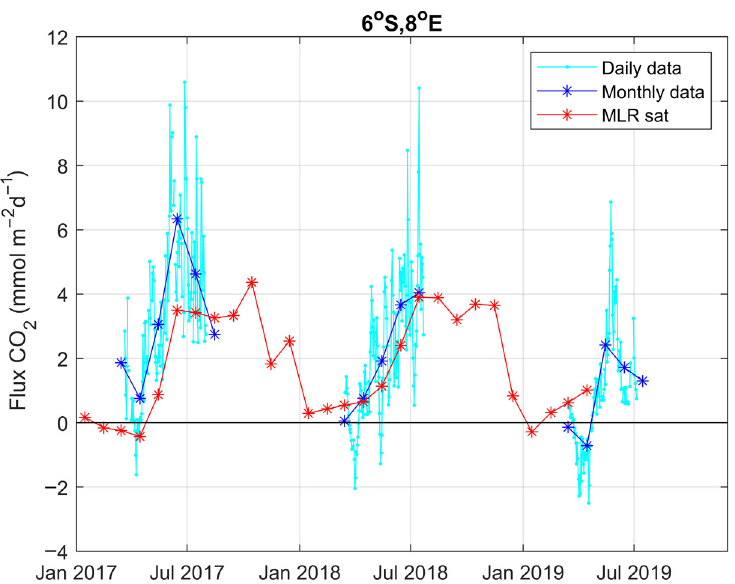
Figure 11. CO 2 flux from daily fCO 2 observations at 6° S, 8° E (in cyan), averaged monthly (in blue)